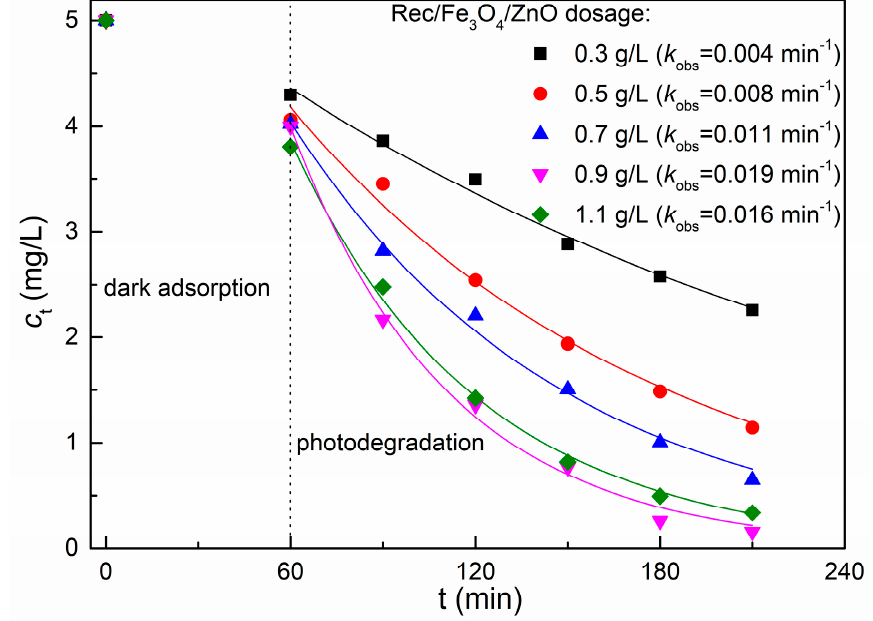
Figure 7. Effect of REC/Fe 3 O 4 /ZnO (1:0.3:0.5) dosage on the adsorption and photodegradation of MB dye.